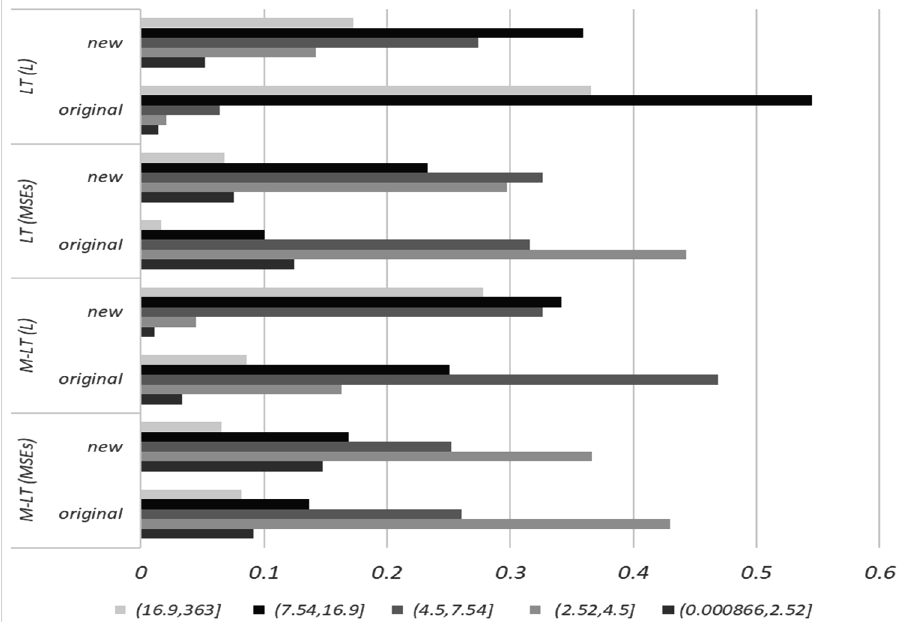
Figure 3. Probability and its change of the output for M-LT and LT enterprises of different size categories (SMEs and L -large) (source: authors’